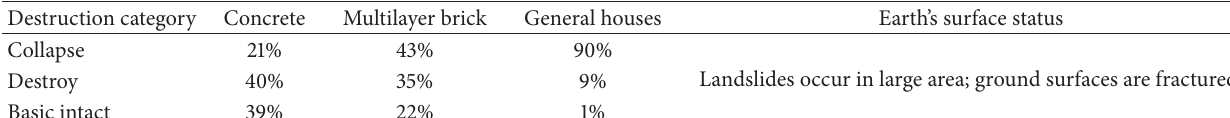
Table 2: Building damage rate in Wenchuan County.